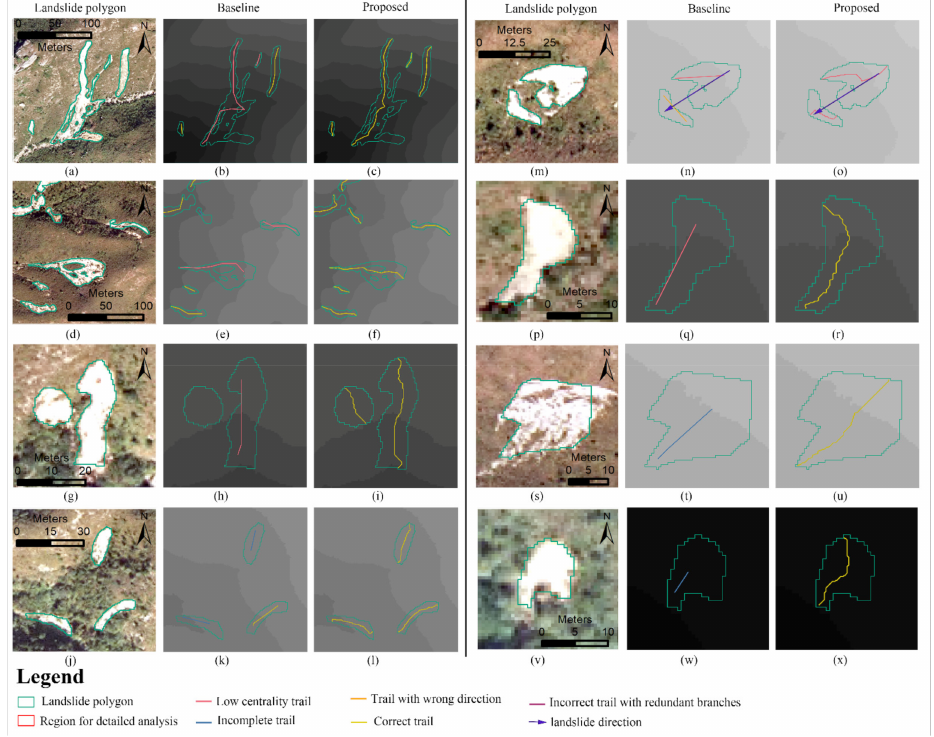
Figure 15. Examples of landslide trail extraction results in study area B. ( a , d , g , j , m , p , s , v ) landslide polygon overlaid on aerial photos; ( b , e , h , k , n , q , t , w ) landslide trail results by the baseline method, overlaid on DEM; ( c , f , i , l , o , r , u , x ) landslide trail results by the proposed method, overlaid on